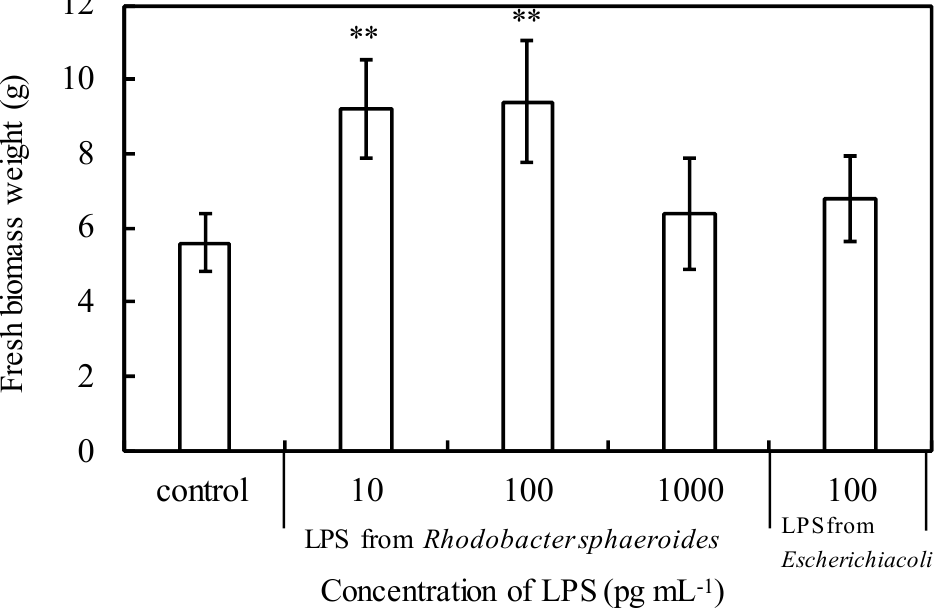
Figure 5. Fresh weight of komatsuna when LPS solutions were sprayed once every 3 days and cultivated for 30 days. Each bar represents the mean ± S.D. ( n = 5). Asterisks indicate significant difference with control at p < 0.01 (**).